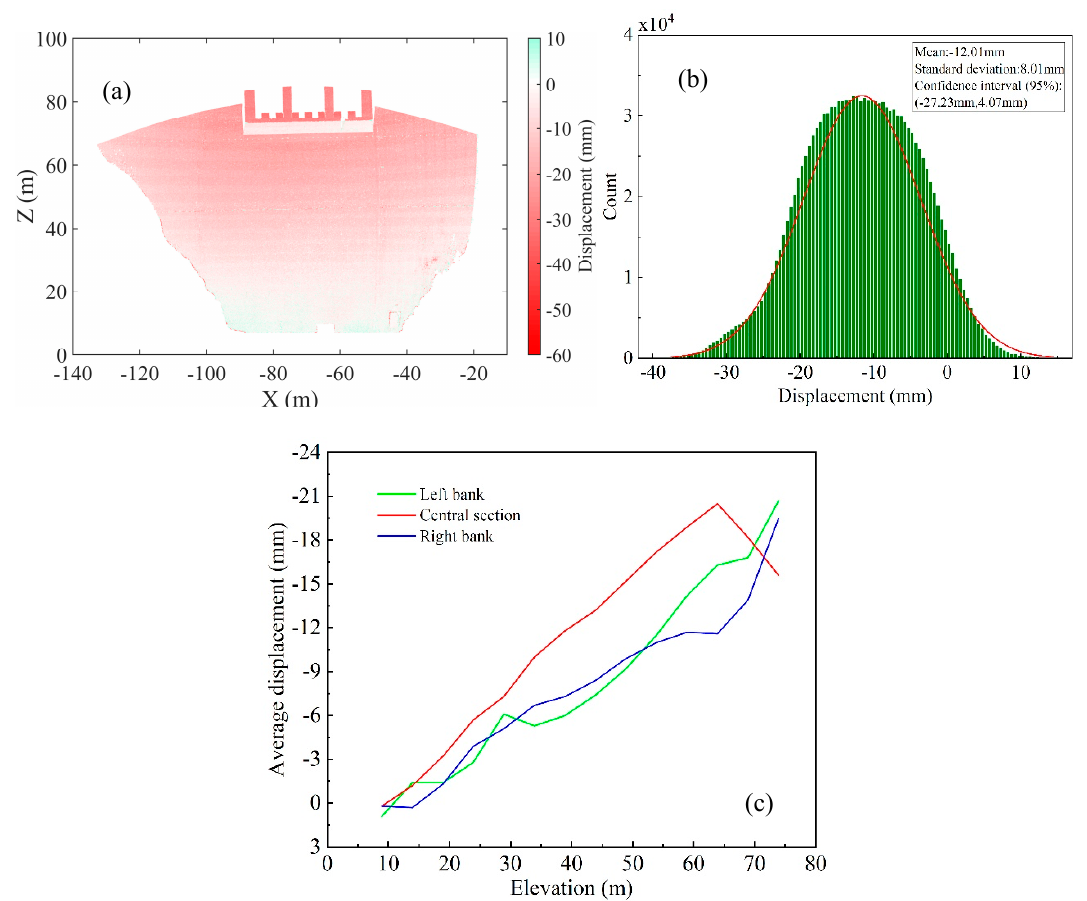
Figure 10. Results of dam displacement changes by point cloud to point cloud (C2C). ( a ) Cloud map of dam displacement variation distribution; ( b ) statistical histogram of displacement changes; and ( c ) average displacement changes of different parts of the dam with different elevations.